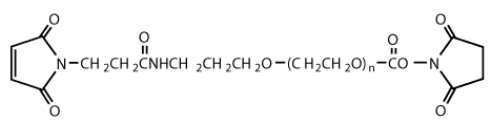
Figure 1. Chemical structural formula of NHS ‐ PEG ‐ MAL.